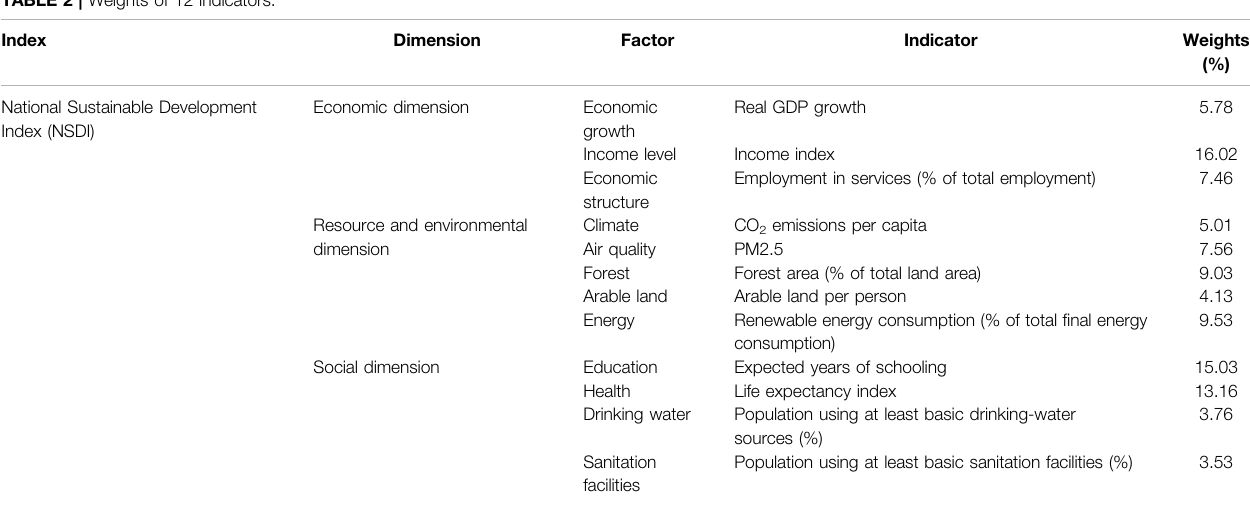
TABLE 2 | Weights of 12